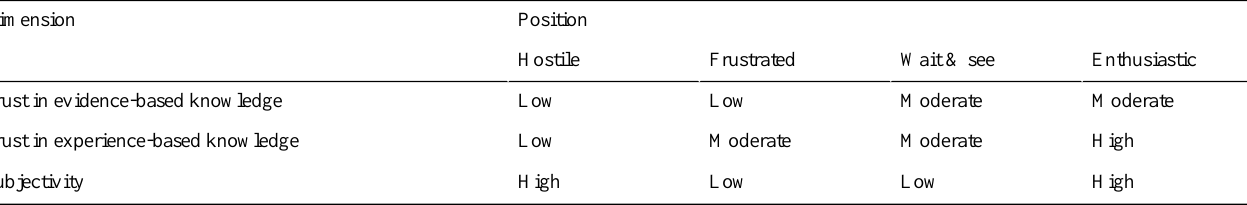
Table 1. Characterization of discourse positions during the chronic cerebrospinal venous insufficiency debate in the Deutsche Multiple Sklerose Gesellschaft (German Multiple Sclerosis Society) patient